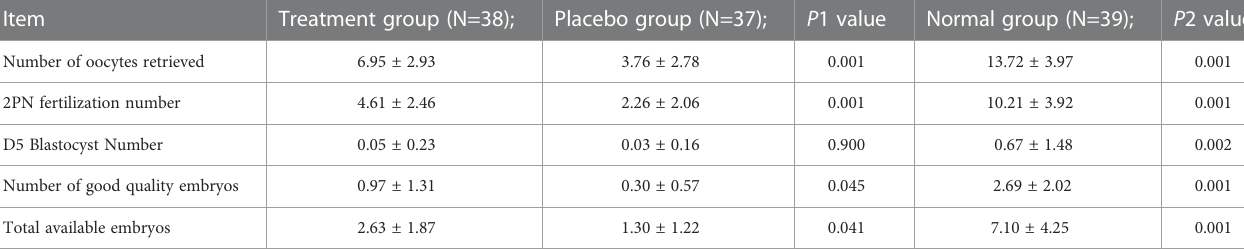
TABLE 3 Comparison of ovulation induction results among three groups ( (cid:1) x ± s).